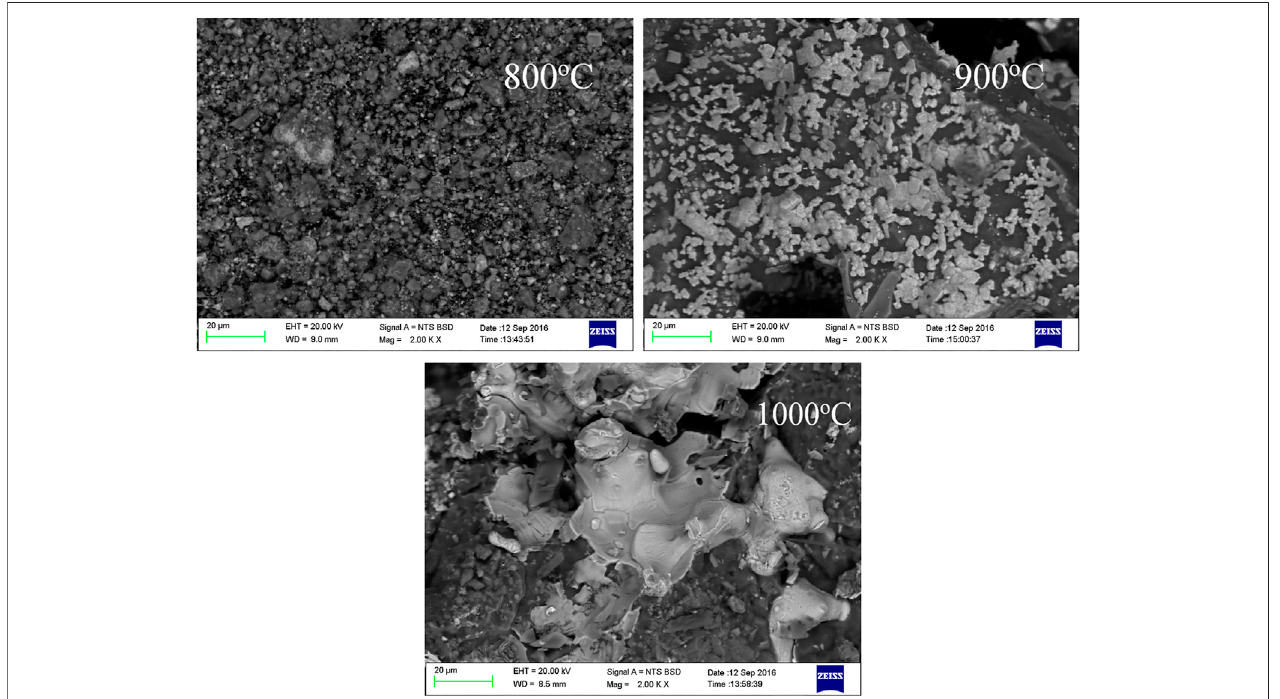
FIGURE 9 | SEM images of roasted laterite ores with Na 2 S 2 O 3 under different roasting temperatures.